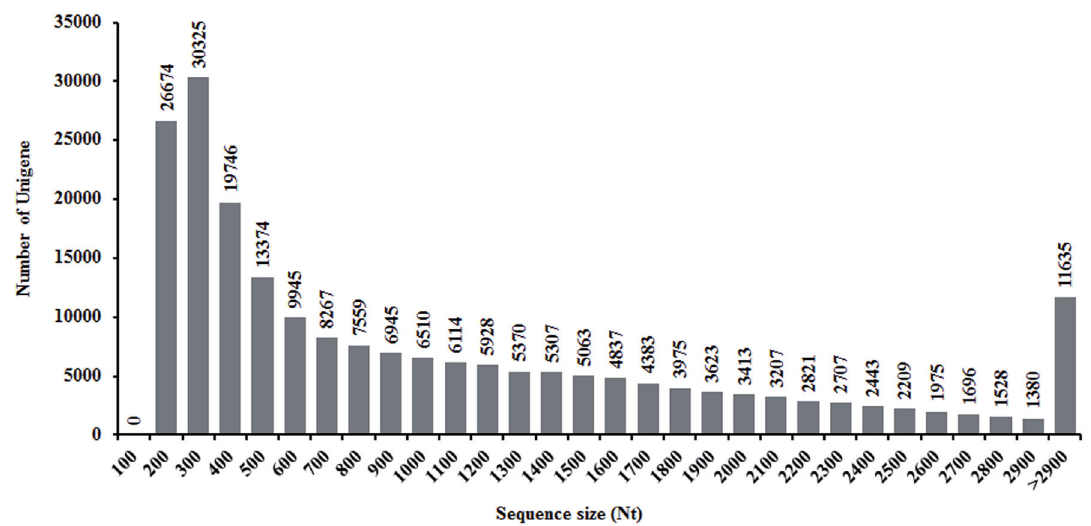
Fig. S1: Length distribution of the assembled